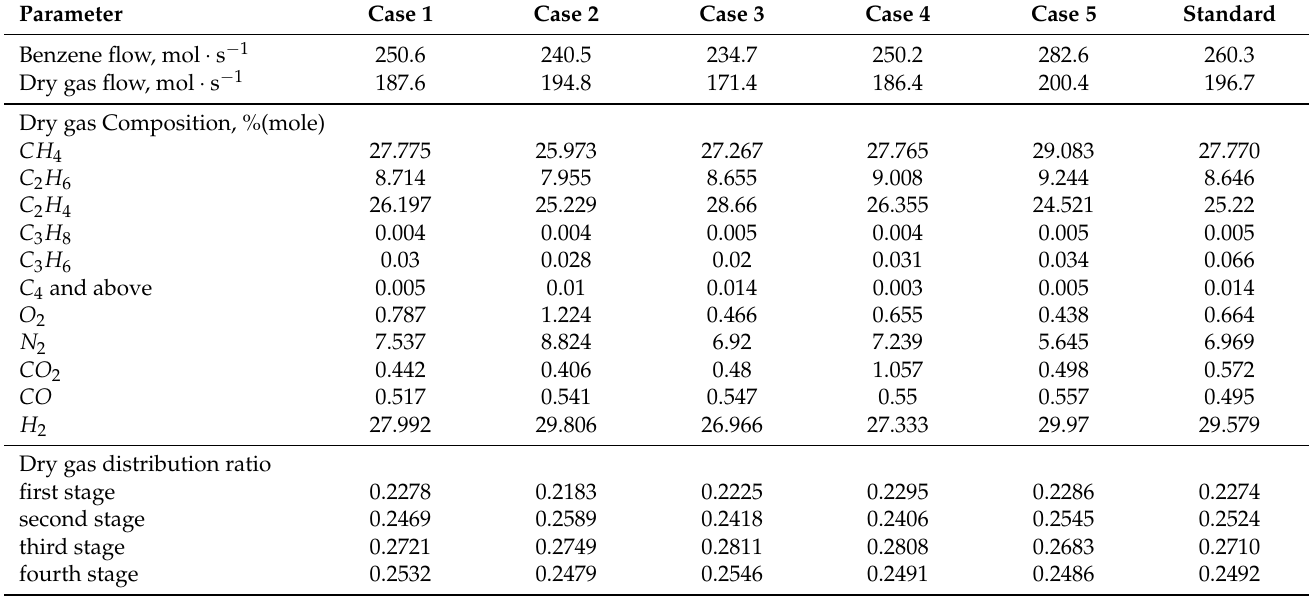
Table 3. Reactor constant parameters.